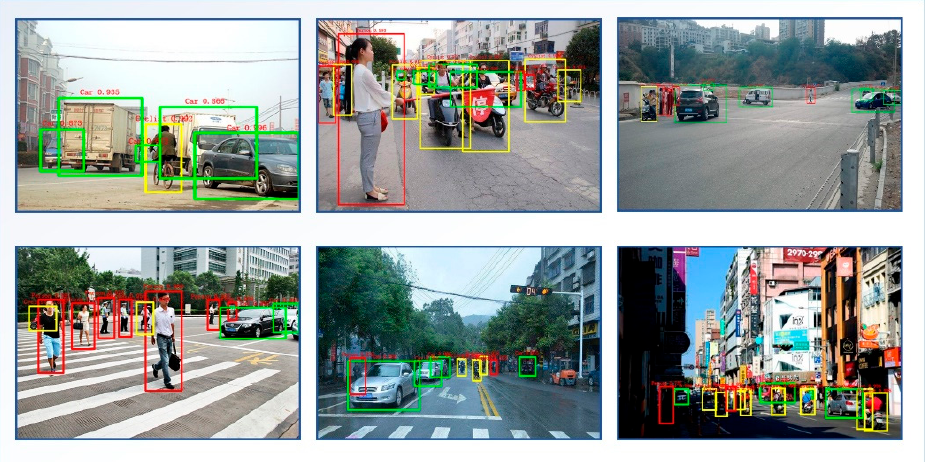
Figure 14. M5 model test results example.